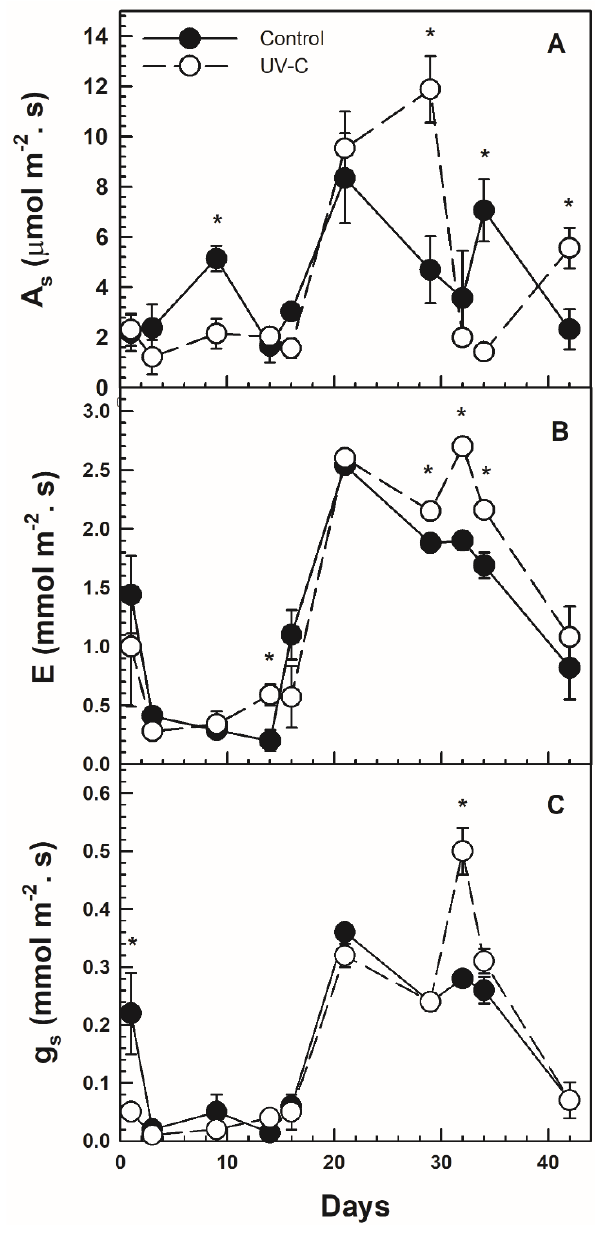
Figure 1. Net CO 2 assimilation ( A ; μmol m −2 . s), transpiration ( B ; mmol m −2 . s) and stomatal conductance ( C ; mmol m −2 . s) of P. × hortorum stem cuttings irradiated with 1 kJ m −2 or left nonirradiated (controls) over a 6-week period. Data ( n = 30) are means per treatment per day ±S.E. Asterisks indicate significant differences between treatment means at p = 0.05.